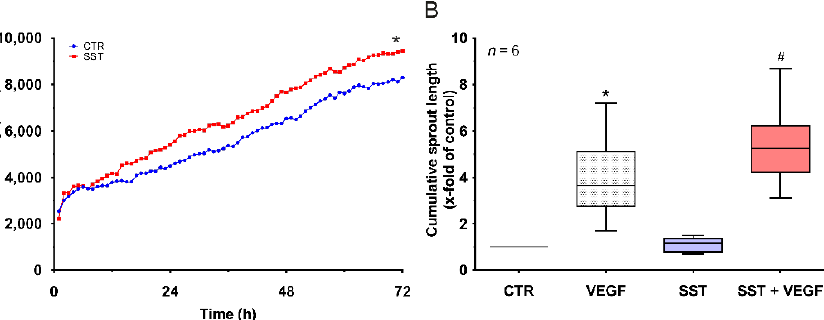
Figure 6. Effect of SST14 on HUVEC proliferation and in vitro angiogenesis (3D Spheroids). (A) Cell density measured by time-lapse live-cell imaging. Cells were treated with 1 nM SST14 or buffer (CTR) under low-growth factor conditions and imaged after every 30 min for a period of 72 h. n=3; p<0.05; * vs. control. (B) 3D spheroid assay. HUVECs were treated with SST14 (1 nM) or buffer (CTR) followed by treatment with VEGF (10 ng/mL). n=6; p<0.05; * vs. control, # vs. VEGF alone.